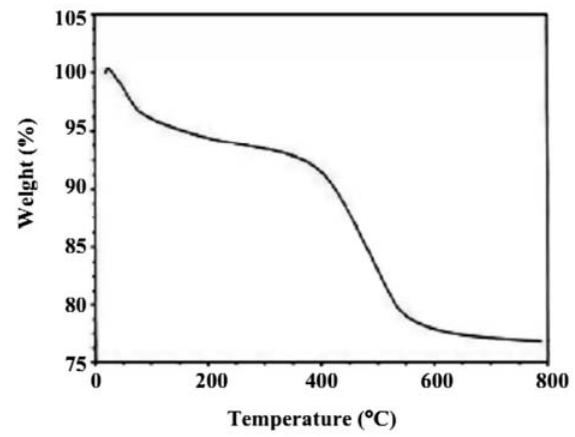
Figure 3. TGA curve of SBA-Pr-SO